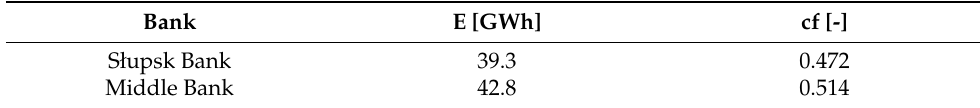
Table 5. Projected energy generation in the V164-9.5MW